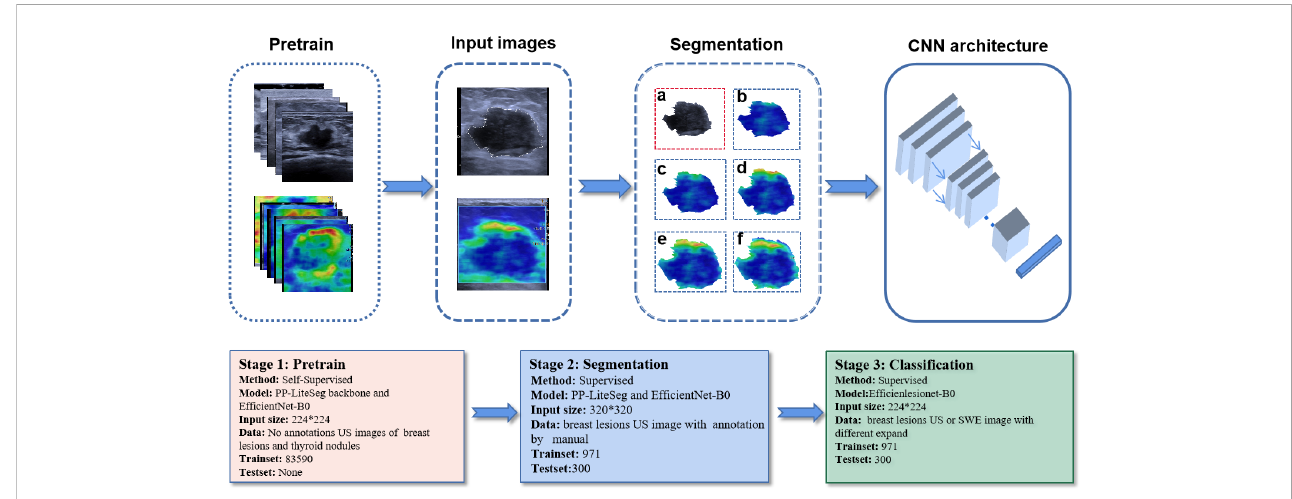
FIGURE 3 The process of model pretraining and segmentation network construction. The trained segmentation model automatically segments the original US and SWE images into six standard data inputs to classi fi cation models: (A) the segmented US image of the lesion; (B) the segmented SWE image of the lesion; (C) the segmented SWE image of the lesion including 0.5 mm of peritumoral tissue; (D) the segmented SWE image of the lesion including 1.0 mm of peritumoral tissue; (E) the segmented SWE image of the lesion including 1.5 mm of peritumoral tissue; (F) the segmented SWE image of the lesion including 2.0 mm of peritumoral